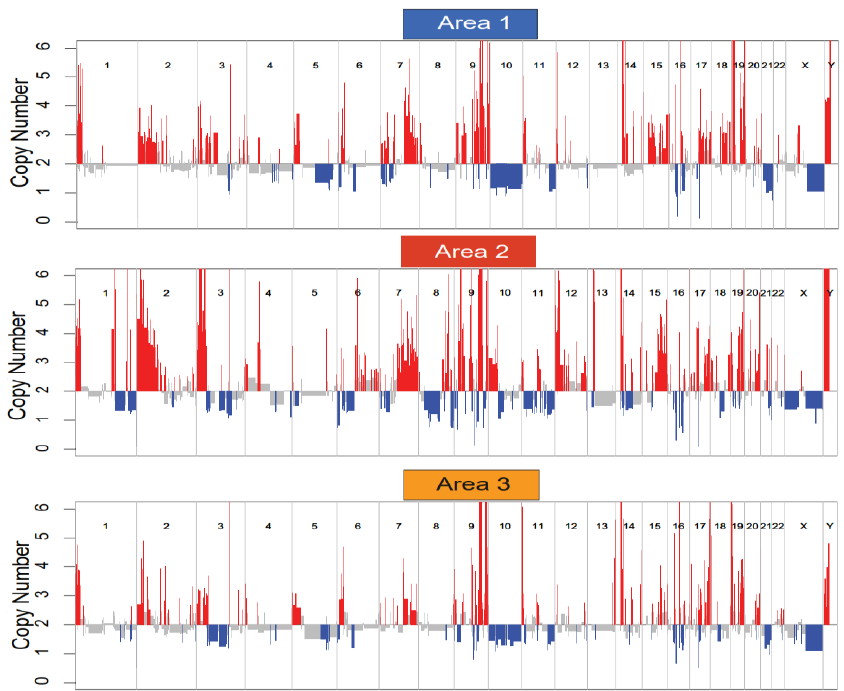
Figure 5. Copy Number Variation Plot. Copy number variation plots for each biopsied site demonstrate distinct copy number signatures.